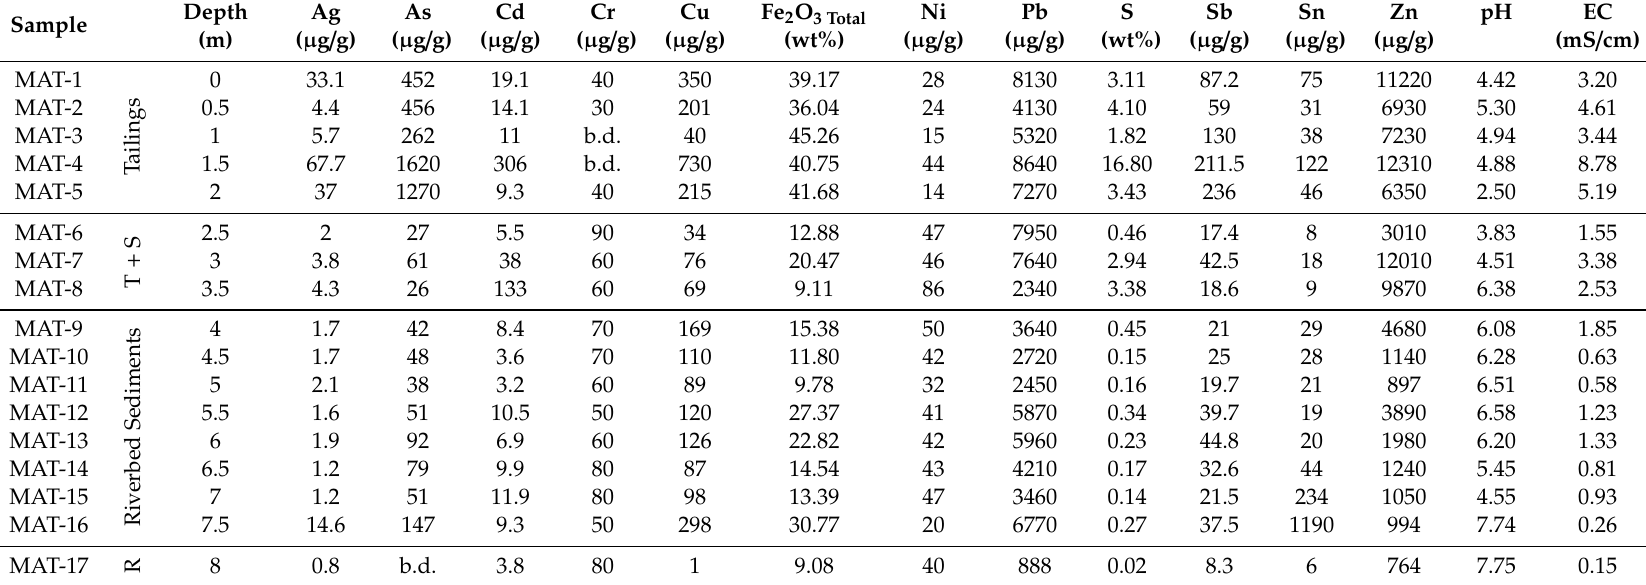
Table 2. Fe 2 O 3 Total and Trace Elements Content, pH, and Electrical Conductivity (EC) Values in the Las Matildes Riverbed Borehole (T + S: Tailings and Riverbed Sediments; R: